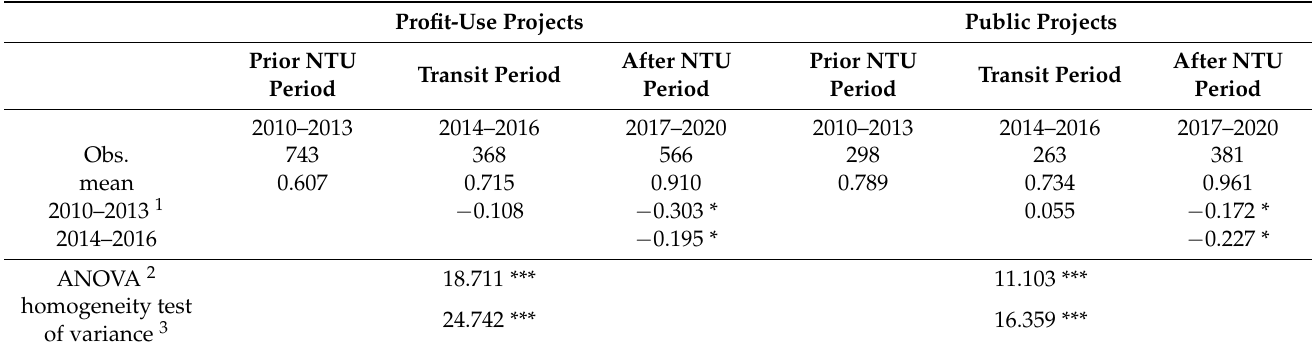
Table 4. Multiple comparisons of land efficiency between different periods.